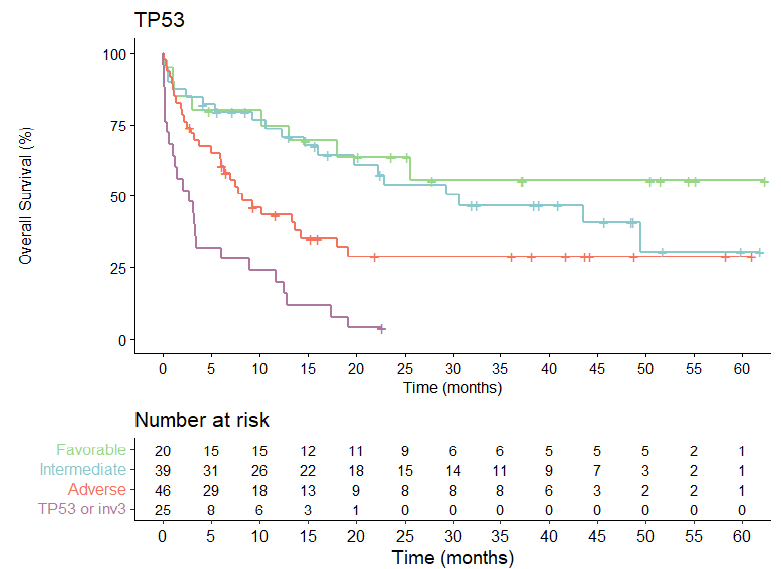
Figure 6. Overall survival probability for the entire cohort ( n = 130) according to the ELN2022 high- risk group defined by the presence of TP53 mutation. high-risk group defined by the presence of TP53